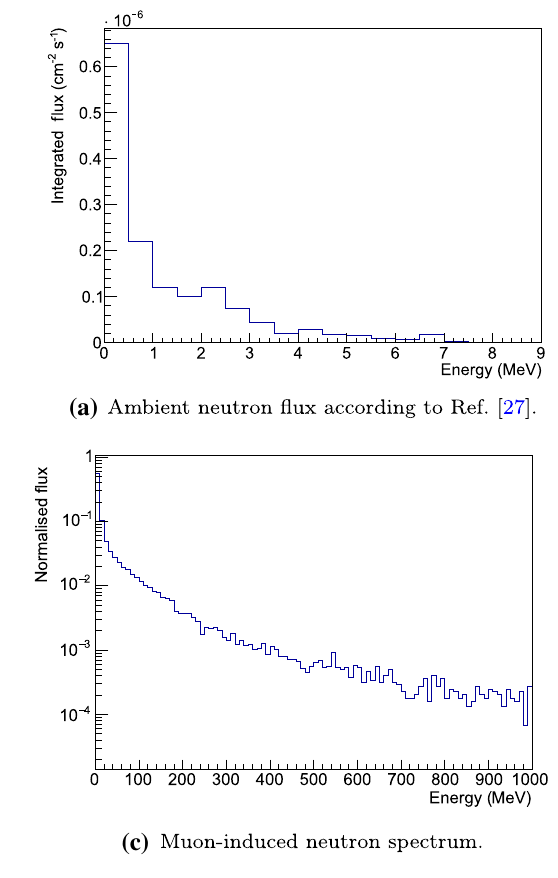
Fig. 5 The plots show spectra of background components external to ourexperimentalsetupandtherespectivefractionsofsurvivingparticles as a function of the thickness of the water layer. The rather low-energy